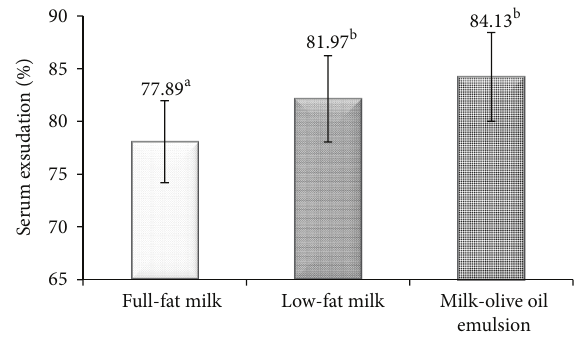
Figure 3: Serum exudation rate evolution of various renneted milk samples. Vertical bars indicate standards errors of the means. Identical letters above the bars indicate no significant differences by Duncan’s multiple-range test ( 𝑃 < 0.05 ).